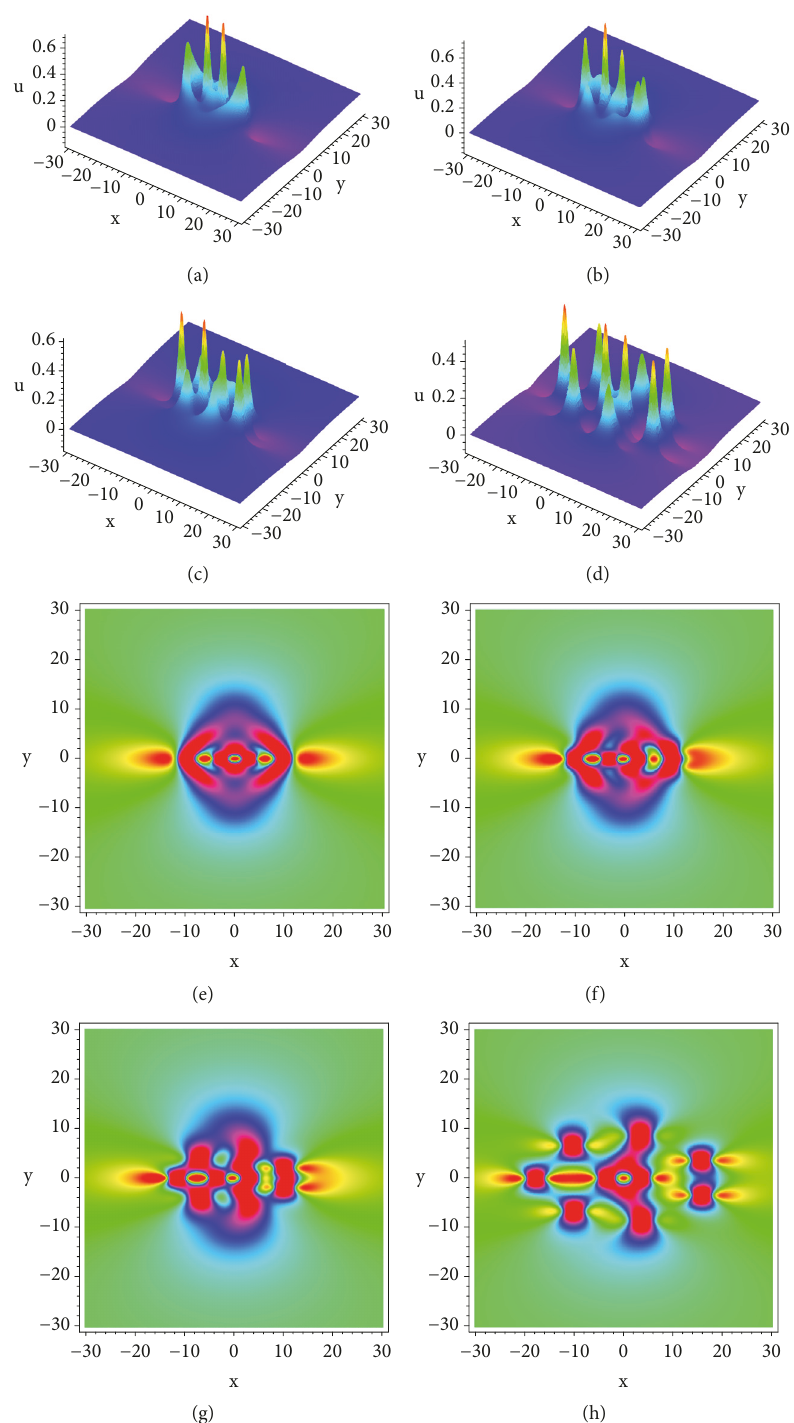
Figure 9: Plots (colored online) of 8-lump wave 𝑢 (21) with 𝑚 = 2, 𝑎 = −2 , 𝑏 0,12 = 𝑐 12,0 = 1,𝑎 18,0 = 600 . (a) Perspective view of the wave 𝑢(𝑥,𝑦, 0) with 𝛼 = 30, 𝛽 = 40 , (b) perspective view of the wave 𝑢(𝑥,𝑦, 0) with 𝛼 = 1 × 10 7 , 𝛽 = 2 × 10 7 , (c) perspective view of the wave 𝑢(𝑥,𝑦, 0) with 𝛼 = 5 × 10 7 , 𝛽 = 7 × 10 7 , (d) perspective view of the wave 𝑢(𝑥, 𝑦,0) with 𝛼 = 8 × 10 8 ,𝛽 = 1 × 10 9 , (e) overhead view of the wave (a), (f) overhead view of the wave (b), (g) overhead view of the wave (c), and (h) overhead view of the wave